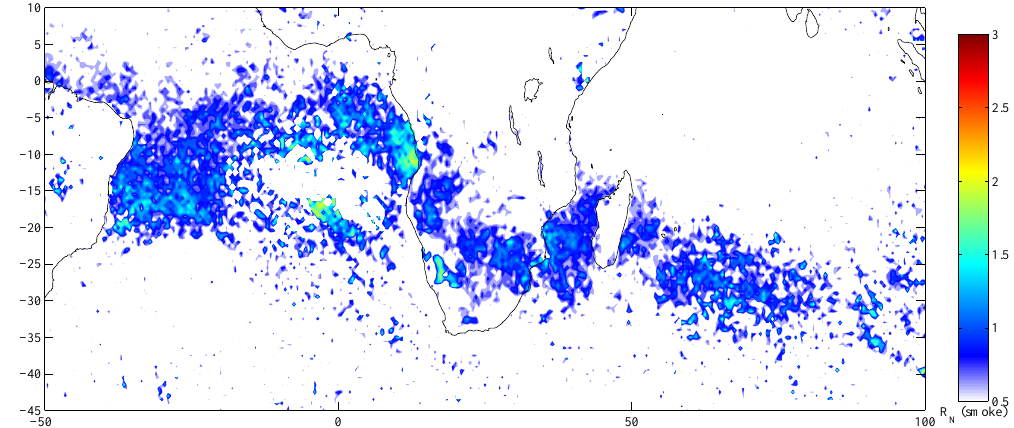
Fig. 12. October 2010 mean value of R N for smoke over the South Atlantic and Indian Ocean.